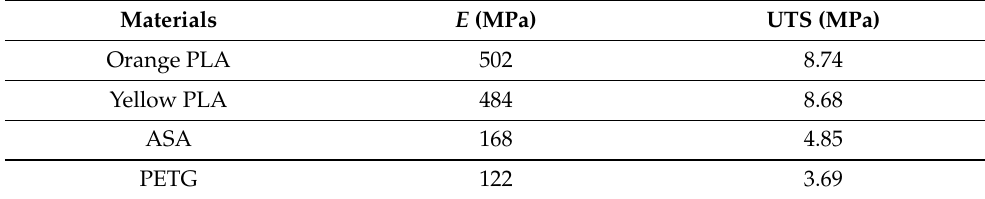
Table 1. Tensile test data for single-material samples.